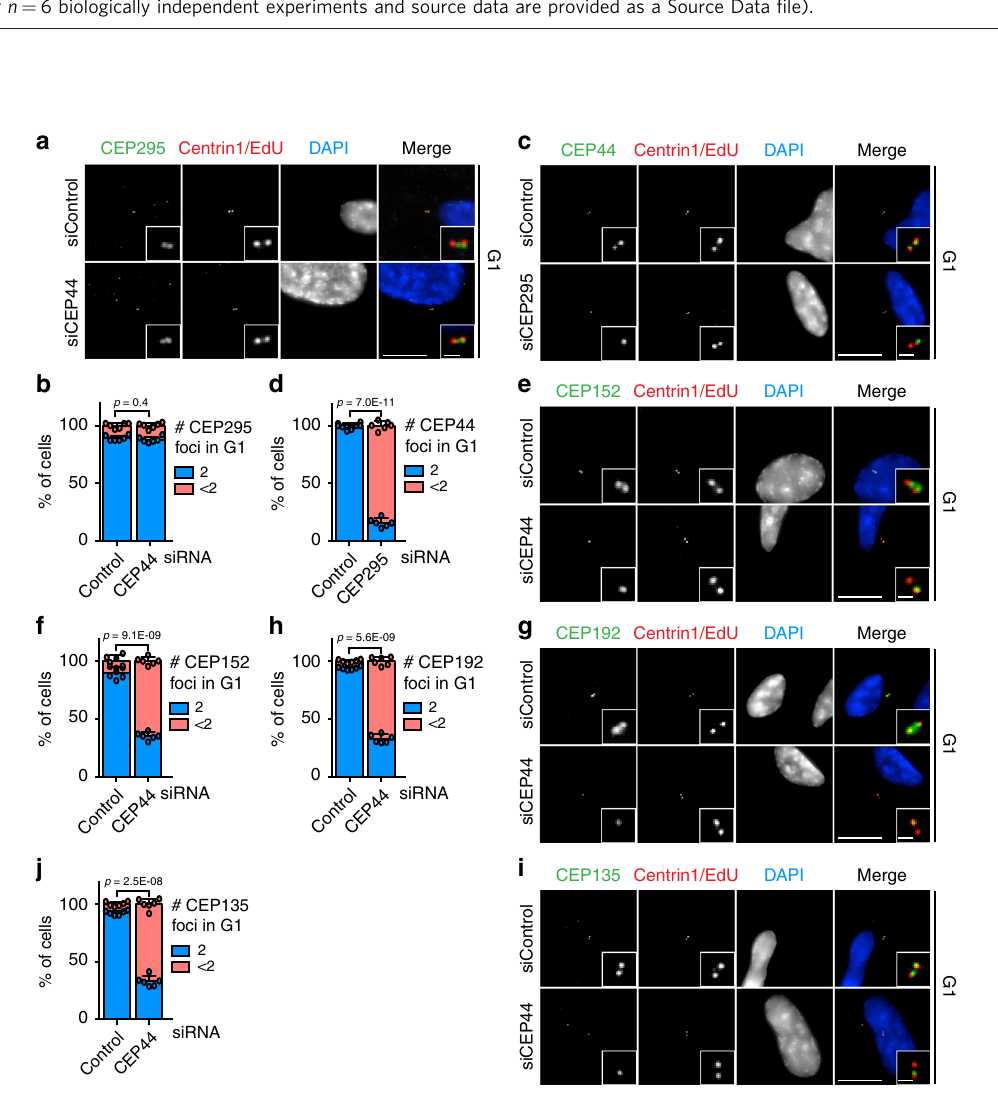
Fig. 1 CEP44 is a centriolar protein necessary for the CCC mechanism. a IF of cycling RPE1 cells showing that CEP44 binds to the new dCs during G2. While S phase cells were detected by EdU stain, G1 and G2 cells were discerned by the lack of EdU stain and the number of centrin1 signals (centrioles). b IF of cells after 72 h of depletion. In the siCEP44 sample (lower panel) G1 cells contained less centrosomes as judged by the number of γ -tubulin foci (Cenp-F in Supplementary Fig. 1b). c Quanti fi cation of b . 80.4 ± 5.0% of G1 cells contained <2 centrosomes. d IF of 60 h siRNA treated RPE1 cells in G1. While the G1 control cells contained 2 de fi ned PCM foci ( γ -tubulin) accompanied by equal number of CEP44 foci, in the siCEP44 sample the loss of CEP44 correlated with inef fi cient PCM ( γ -tubulin) recruitment to only one (bottom panel) or both centrosomes (middle panel) (Cenp-F, Supplementary Fig. 1g). e Quanti fi cation of CEP44 loss in d . 65.1 ± 7.3% of G1 cells contained <2 CEP44 foci. f Quanti fi cation of γ -tubulin de fi ned foci in d . 60.7 ± 4.2% of G1 cells contained <2 de fi ned γ -tubulin signals. g , h G2 CEP44-depleted cells after 60 h of CEP44 depletion showed a mild centriole duplication defect as judged by the counting of CEP97 foci (<4). g Quanti fi cation of h . 30.3 ± 4.1% of CEP44-depleted cells contained <4 centrioles. i MT regrowth assay in RPE1 C-Nap1 KO cells. The non-converted daughter centrosome without CEP164 staining regrew lower numbers of MTs (5.1 ± 2.7 MTs/centrosome) than the siControl daughter centrosomes (10.3 ± 3.0 MTs/centrosome) upon cold treatment and MT regrowth. j Quanti fi cation of i . k Loss of CEP44 leads to misalignment of mitotic spindles (>65%) generating either bipolar asymmetric spindles (51.3 ± 4.7%) or mono-/multipolar ones (14.3 ± 4.0). l Quanti fi cation of k . ( a , b , d ,